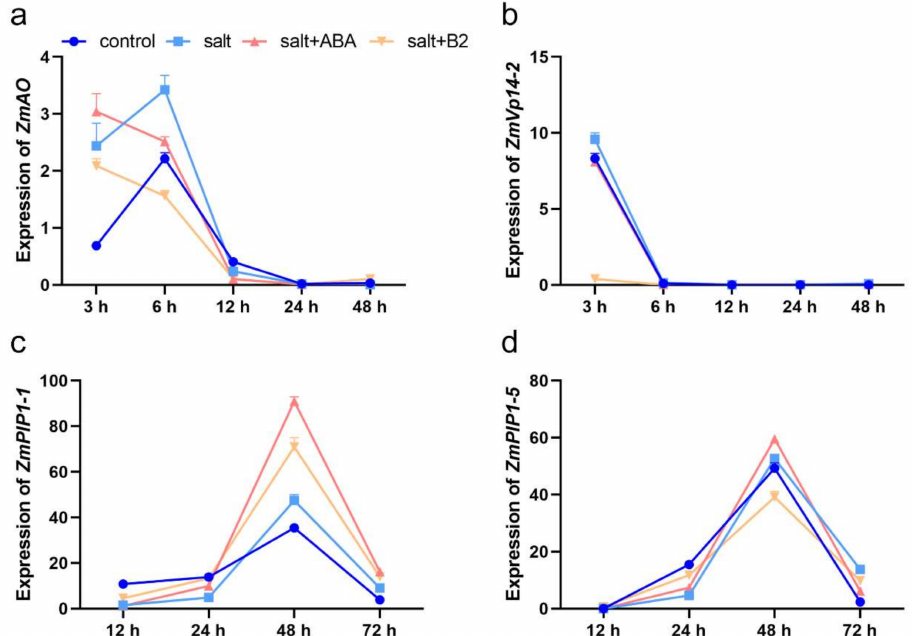
Figure 9. The expression levels of aquaporin and ABA biosynthesis genes. ABA was 100 µ M and B2 concentration was 1 µ M. ( a ) The expression level of ZmAO gene. ( b ) The expression level of ZmVP14-2 gene. ( c ) The expression level of ZmPIP1:1 gene. ( d ) The expression level of ZmPIP1:5